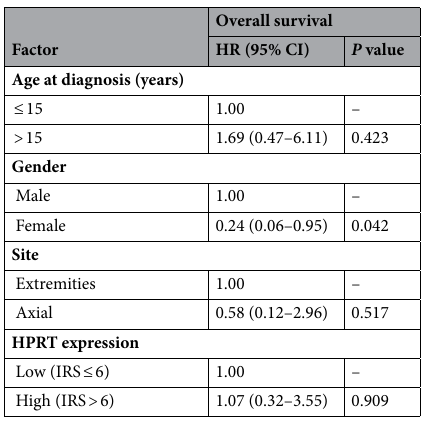
Table 8. Multivariate analysis of metastasis-free survival in osteosarcoma patients and HPRT expression in post-chemotherapy tissues (n = 20).